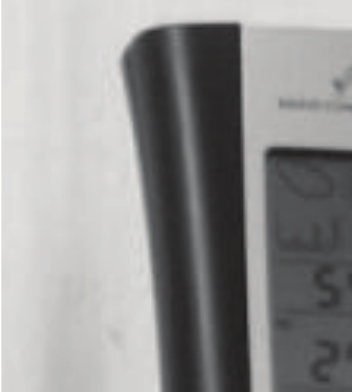
Figure 11: Example of “ghost” artefact reduction by ESA.